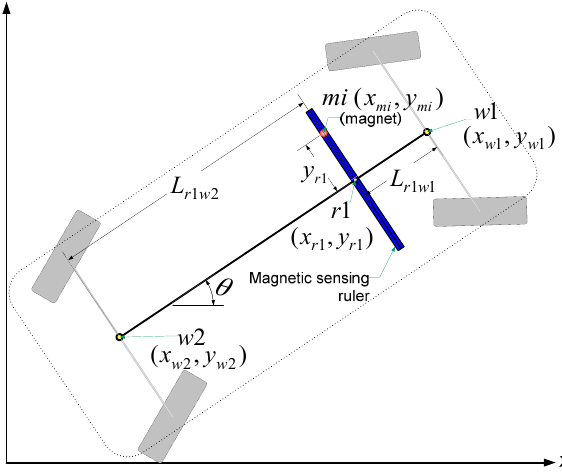
Figure 7. Vehicle configuration and measurement model.